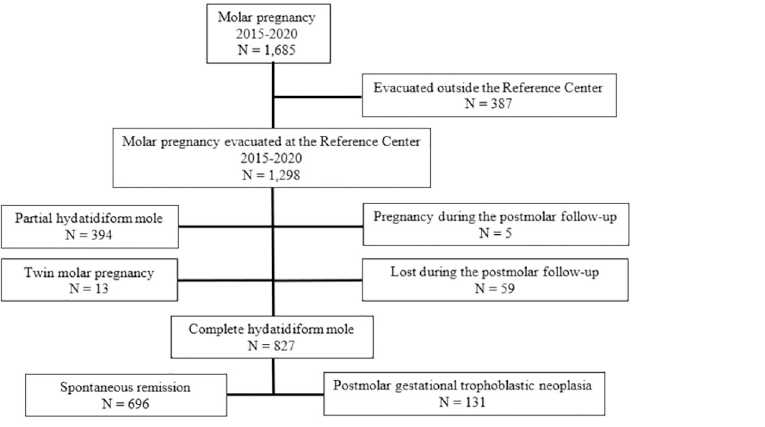
Fig 1. Flow diagram summarizing the derivation of the study population.